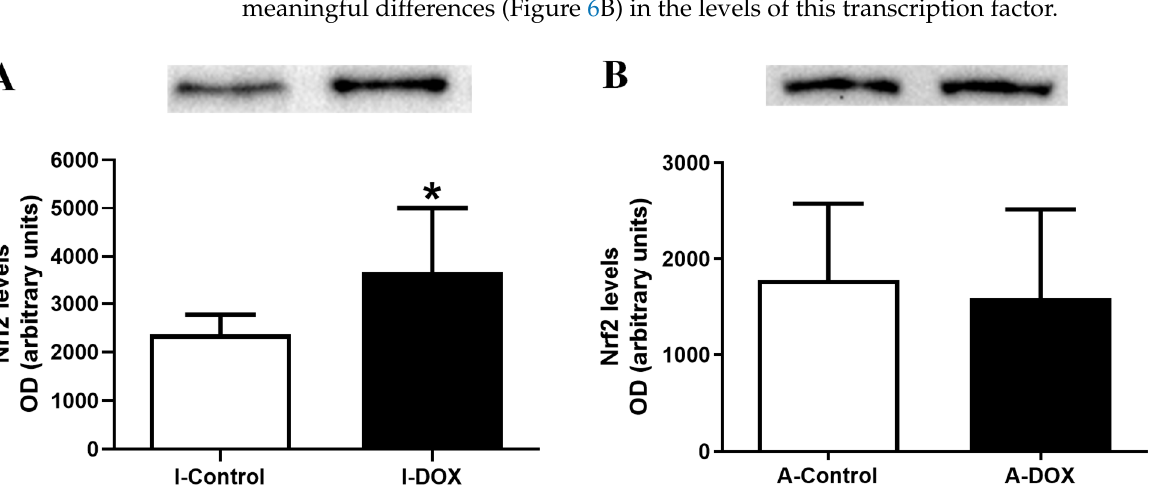
Figure 6. Nuclear factor erythroid-2 related factor 2 (Nrf2) (97 kDa) levels in the cardiac tissue evaluated by Western blotting, in ( A ) infant DOX-treated (I-DOX) and control mice (I-Control), and ( B ) adult mice exposed to a cumulative dose of 18.0 mg/kg DOX (A-DOX) and respective controls (A-Control). Values are expressed as mean ± SD and were obtained from 6 infant or 7 adult animals from each treatment group. Statistical comparisons were made using Student’s t -test: * p < 0.05, DOX vs. control. OD: optic density. Protein loading was confirmed by the Ponceau S staining (Figure S1).